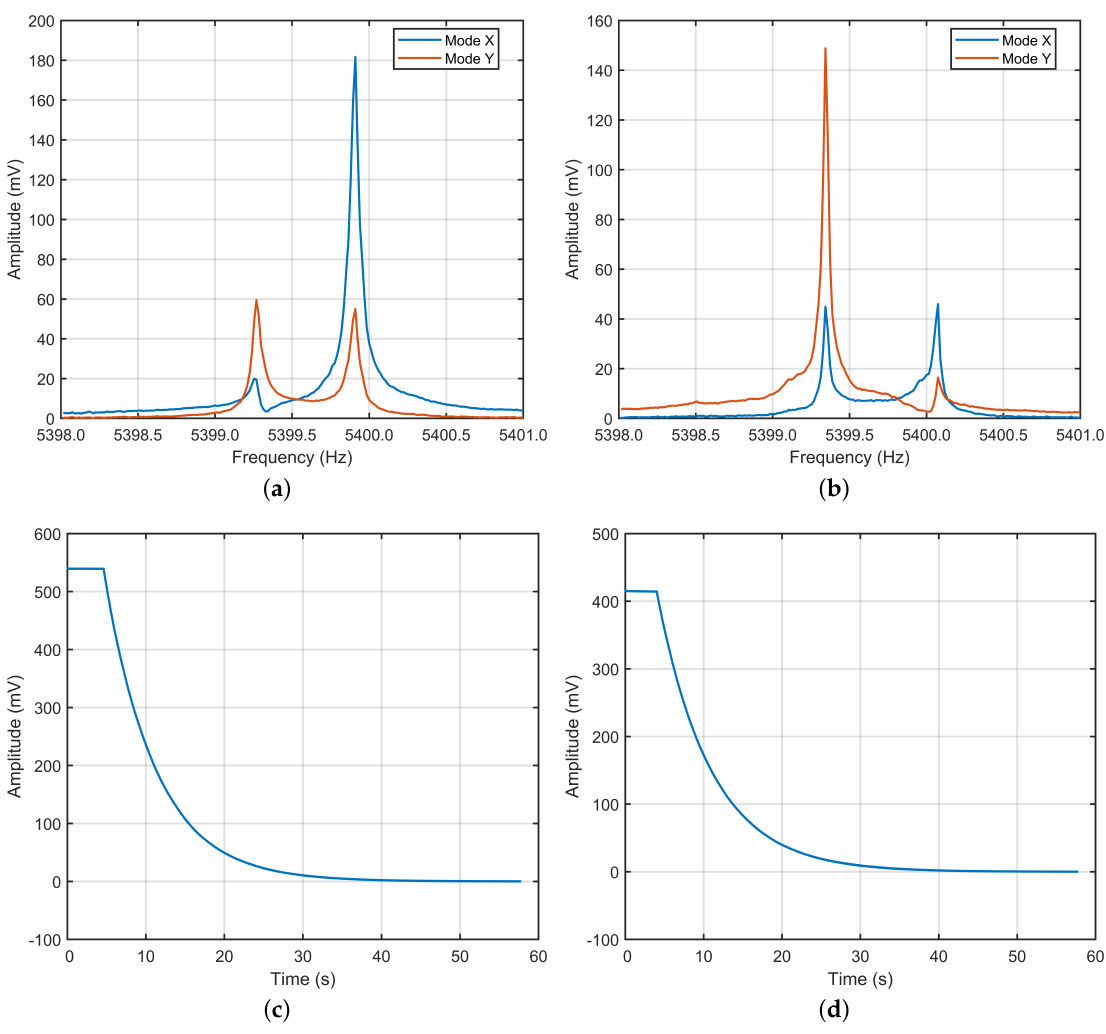
Figure 8. The initial state of the gyro. ( a ) The frequency characteristic of gyro when mode X is excited. ( b ) The frequency characteristic of gyro when mode Y is excited. ( c ) The ring down process of mode X. ( d ) The ring down process of mode